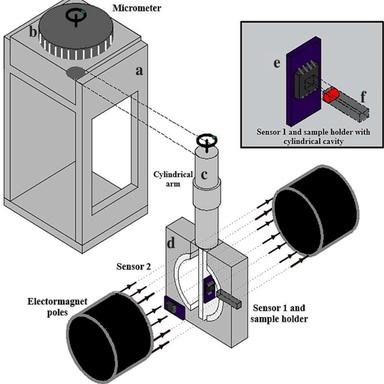
Components of the constructed magnetometer: (a) Acrylic structure ; (b) Micrometer; (c) Cylindrical arm ; (d) Acrylic piece (45 × 45 × 25 mm3 ) connected to the arm; (e) Circuit board (8 × 32 × 2 mm3 ) on which two AD22151 Hall-effect sensors are mounted; (f) Acrylic sample holder (5.0 × 3.0 × 30 mm3 ); (g) electromagnet pole (diameter: 40 mm).